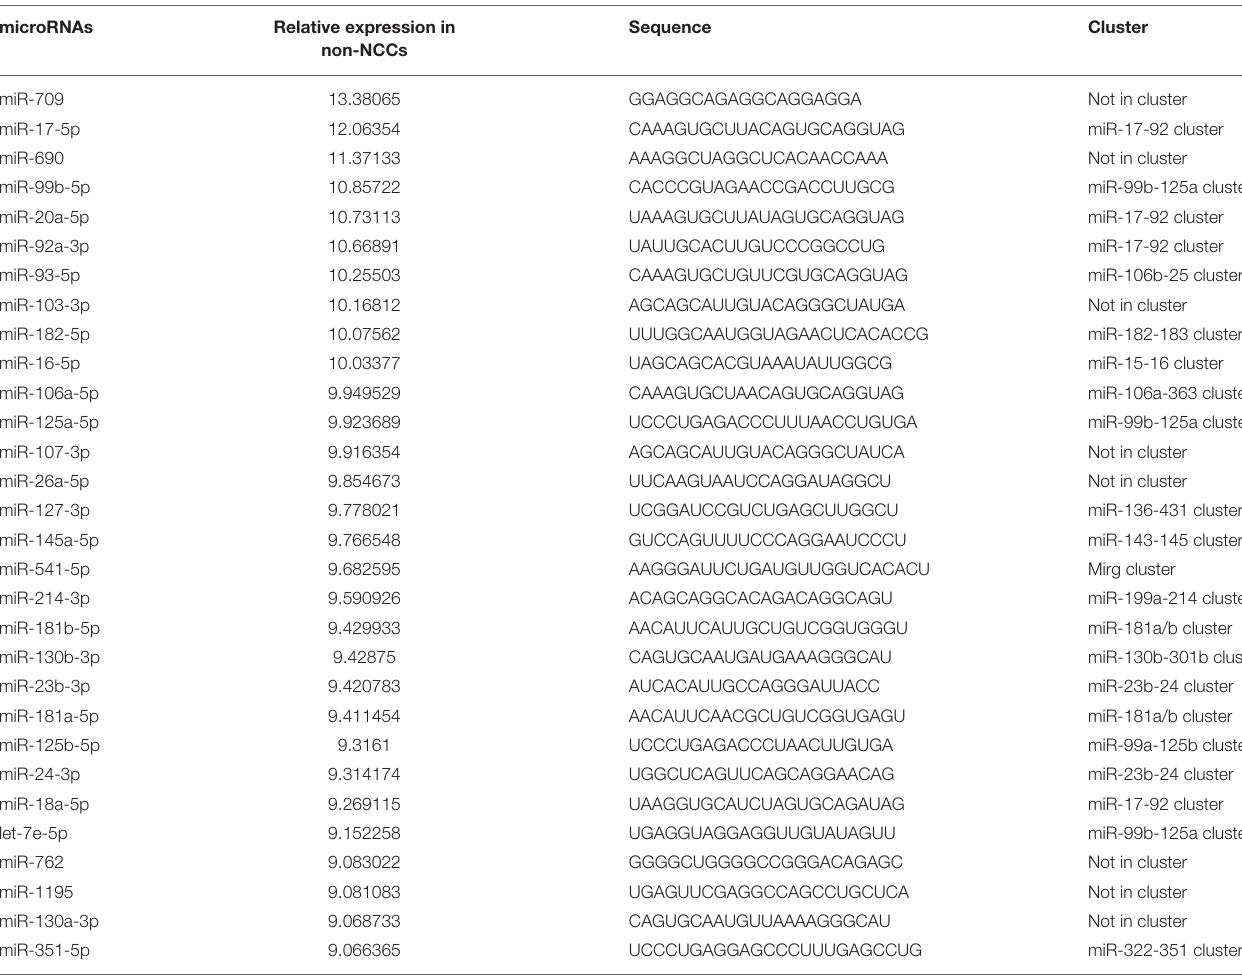
TABLE 2 | Top 30 most abundant miRNAs in non-NCCs.